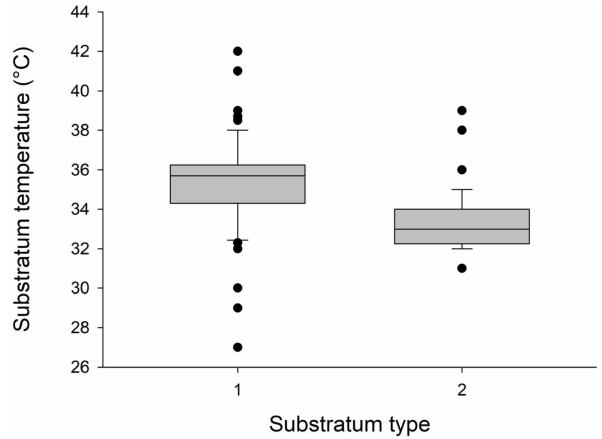
Figure 4. Box plots showing differences between substratum tem- perature ( ◦ C) at electric panels (symbol 1 on the x axis) and at non- artificially heated locations used by lizards (symbol 2 on the x axis). Mean, range, standard deviation and outliers are